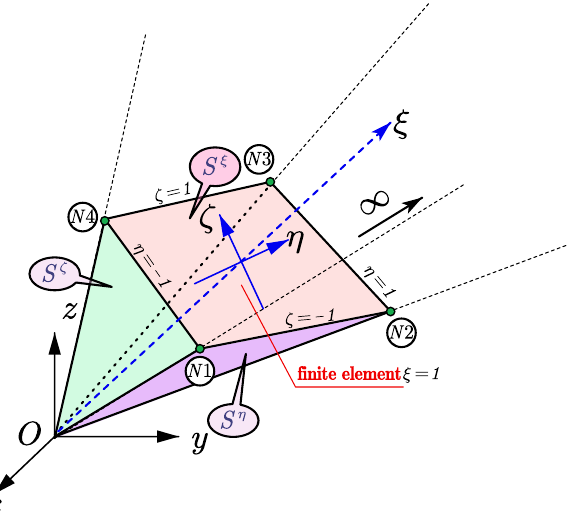
Figure 3. Spatial discretization of the